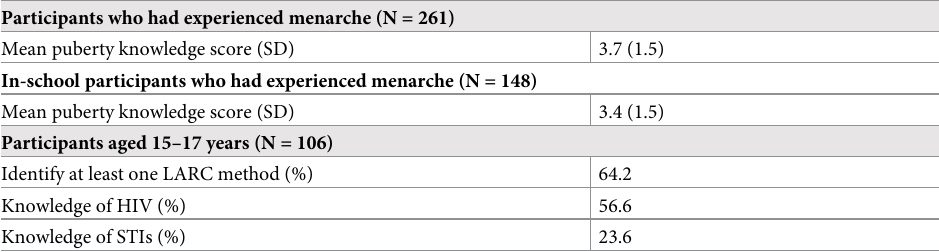
Table 3. Summary statistics for knowledge outcomes.